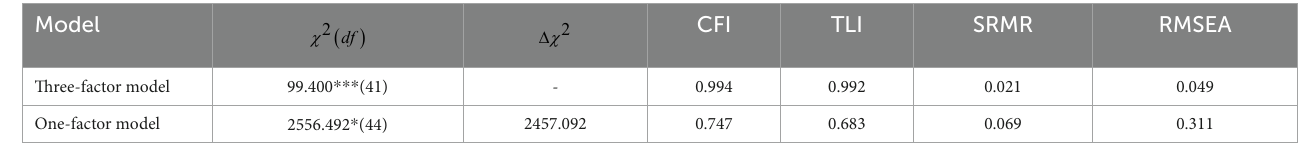
TABLE 2 Results of confirmatory factor analysis.